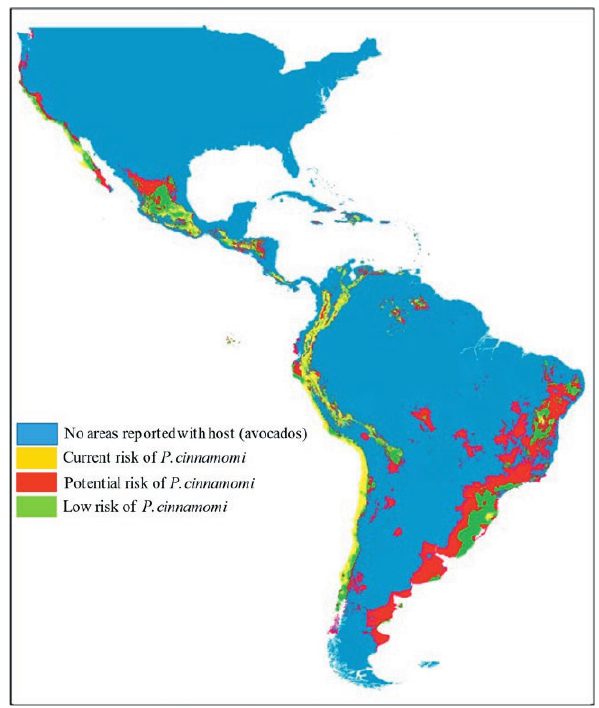
Figure 4. Risk visualization of Phytophthora cinnamomi on avocado (cultivated and native races) in the